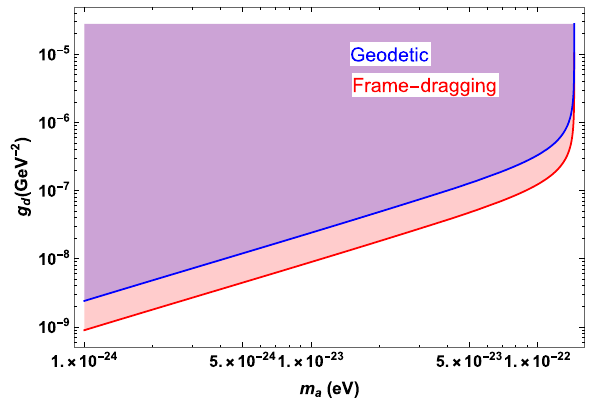
Fig. 2 Variationof g aNN with m a forthegeodetic(blue)andtheframe- dragging (red) measurements using GP-B result for time oscillating background axionic field. The shaded regions above these lines are excluded